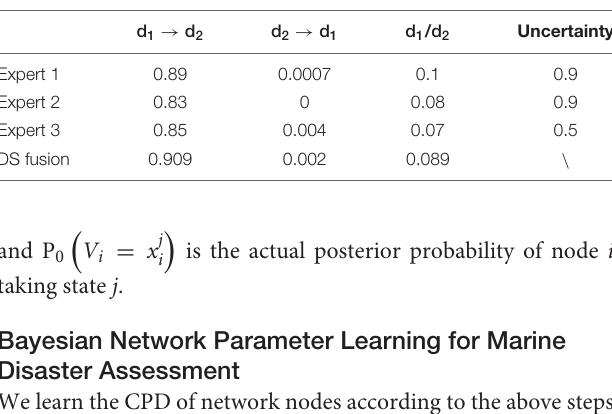
TABLE 4 | Expert knowledge fusion of nodes d 1 and d 2